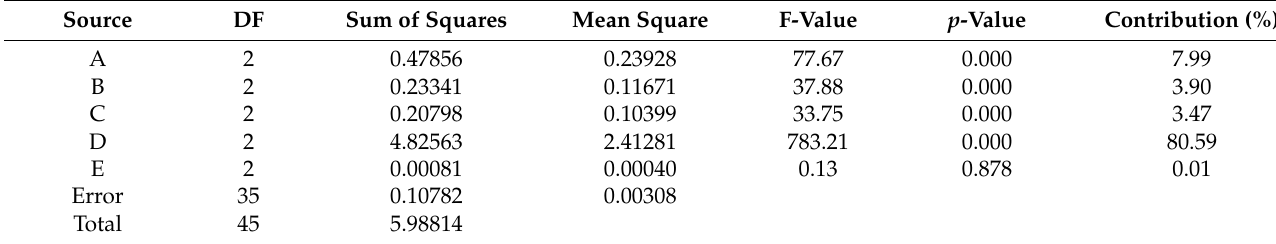
Table 11. ANOVA for addendum diameter shrinkage.